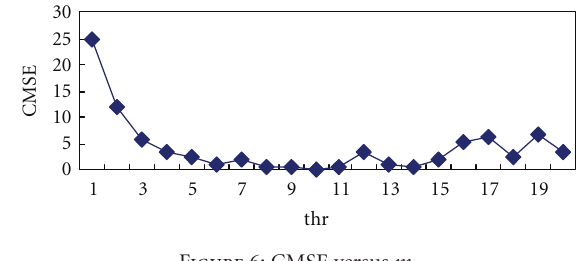
Figure 6: CMSE versus m .